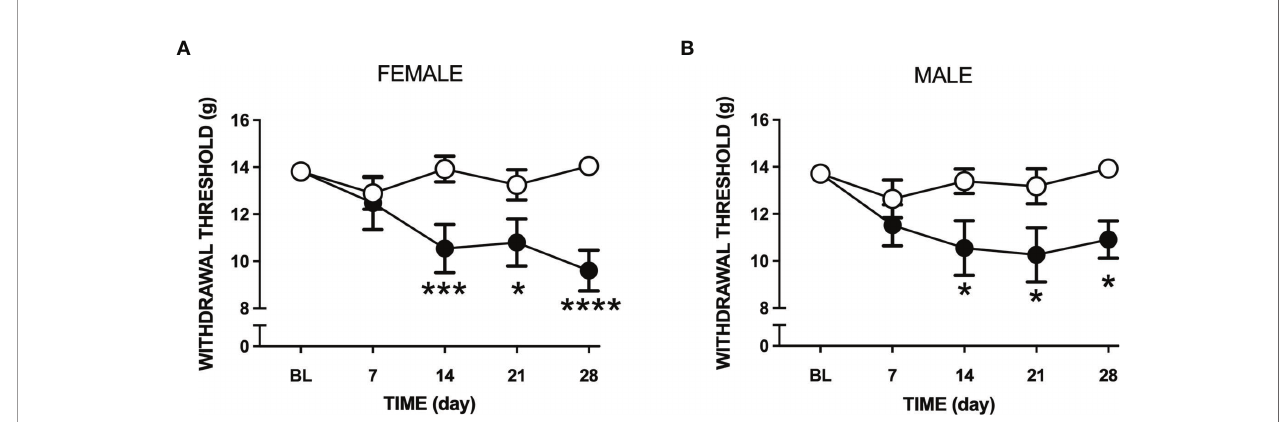
FIGURE 3 | Changes in tactile sensitivity to von Frey hair fi laments following LPA treatment. Mechanosensitivity in vehicle (open circles) and LPA-treated (closed circles) female (A) and male (B) rats over 28 days following intra-articular injection of LPA. Secondary allodynia gradually developed over the time course and was still present at day 28. (*P < 0.05; ***P < 0.001; ****P < 0.0001 two-way ANOVA with Holm-Sidak post hoc multiple comparisons test; n =12-24 animals/group). Data are means ±